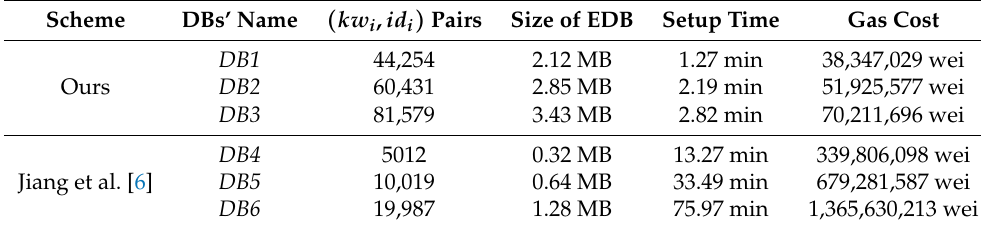
Table 4. Performance comparison of SetupDB